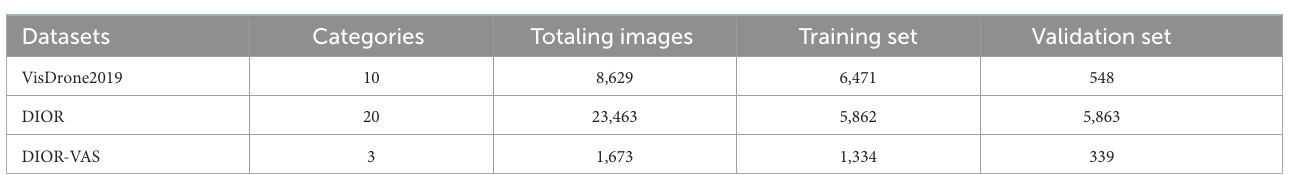
TABLE 1 Hyperparametric configuration of the experiments. Hyperparametric Configuration TABLE 2 Details of the VisDrone2019 and DIOR datasets. Datasets